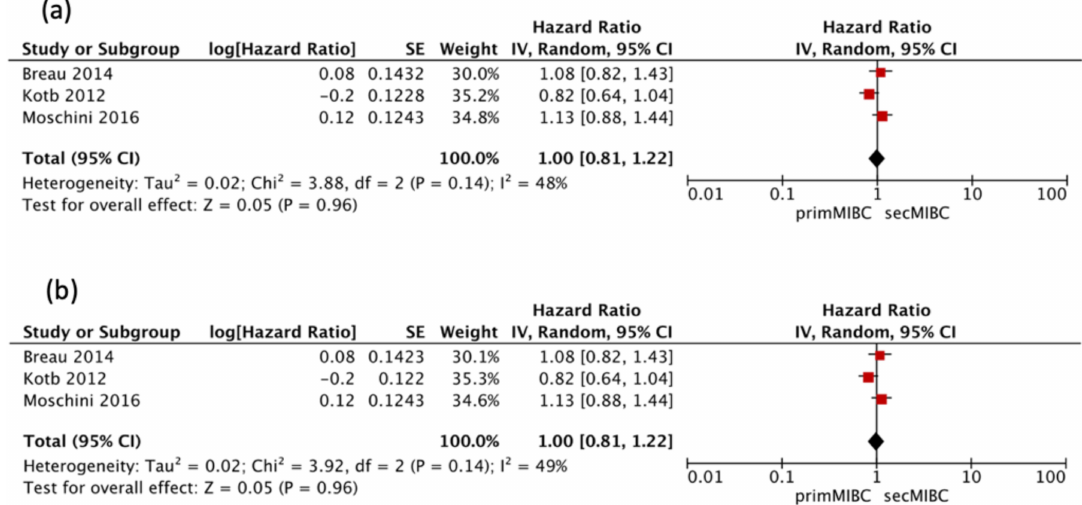
Figure 2. ( a ) Forest Plot for 5-year OS after RC, ( b ) Forrest Plot for 10-year OS after